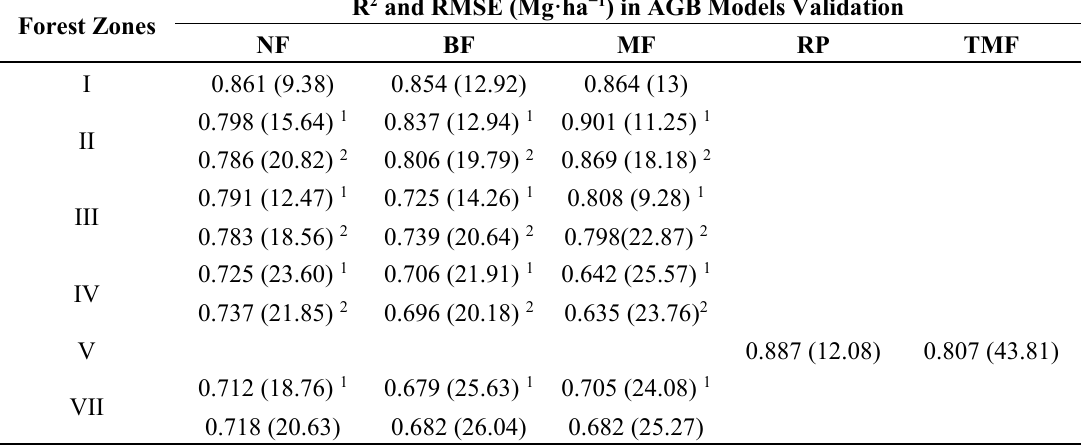
Table 6. AGB predicted from GLAS data were compared with biomass converted from forest inventory data in six forest zones. R 2 and RMSE (in parentheses) values correspond to each forest type within six forest zones. NF = needleleaf forest, BF = broadleaf forest, and MF = mixed forest, RP = rubber plantation, TMF = tropical monsoon forest. Numbers (R 2 and RMSE) with superscripts 1 and 2 correspond to estimation models from GLAS footprints on slopes <20° and ≥ 20°. I is cold temperate zone, II is temperate zone, III is warm temperate zone, IV is subtropical zone, V is tropical zone and VII is Qinghai-Xizang plateau alpine zone